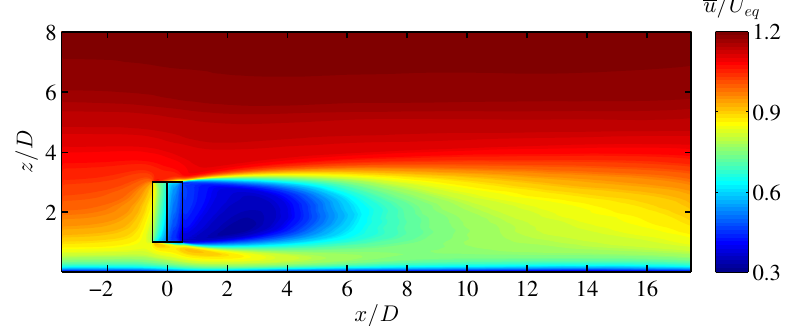
Figure 7. Contours of the normalized mean streamwise velocity ( u / U eq ) in the x - z plane going through the center of the turbine.